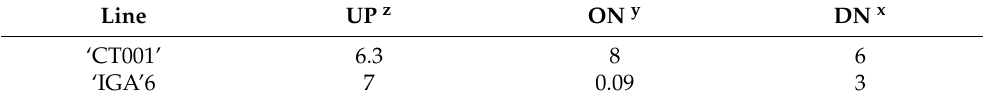
Table 1. PTE-2 -excised detection combine mapping and read depth coverage. Table 2. PTE-2 copy elements at different loci in ‘CT001’ genome.